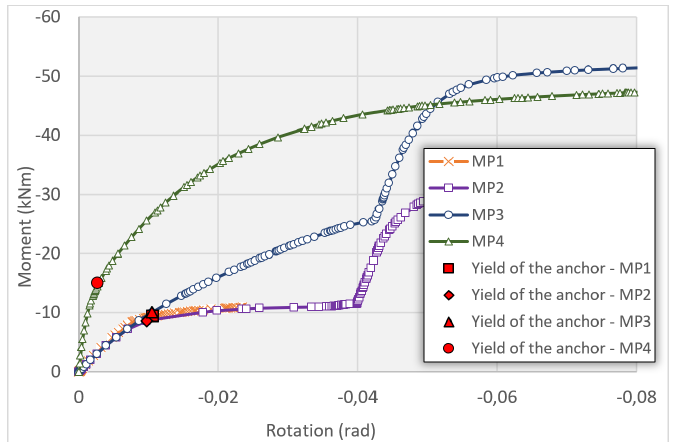
Figure 17. MP1, MP2, MP3, and MP4 moment-rotation curve.